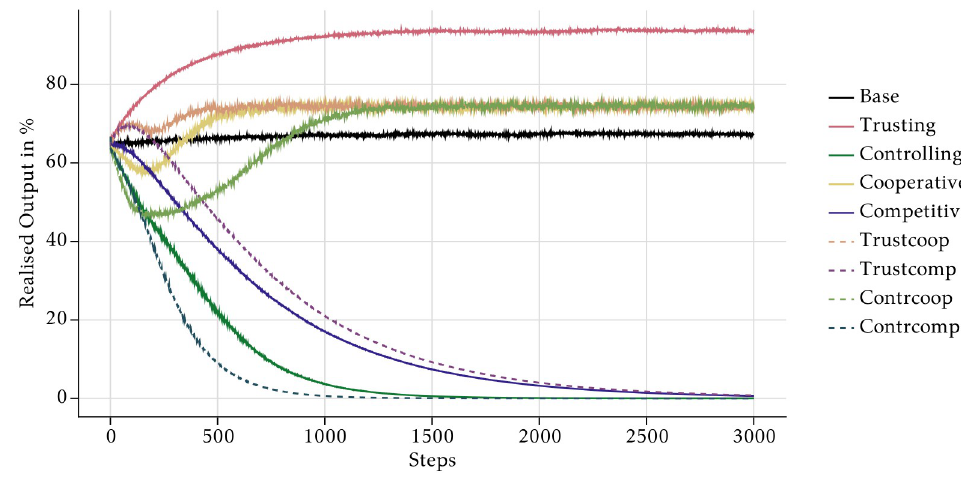
Fig 8. Aggregate realised output per